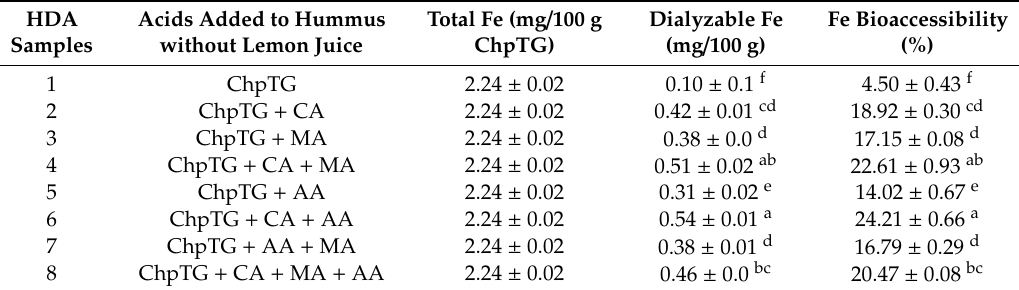
Figure 4. Percentage of iron bioaccessibility (dialyzable iron content (mg/100 g) divided by the total iron content (mg/100 g)) in the eight samples of HDA chosen based on the 2 3 experimental design (full factorial). (HDA: hummus with different acids). Results are expressed as a mean ± IC ( n = 3; IC 95%). Bars not sharing a letter are significantly different ( p < 0.05), according to the one-way ANOVA test followed by Tukey’s post-hoc test at 95% confidence. ChpTG = Chp: chickpea + T: tahini + G: garlic. CA: citric acid, MA: malic acid, AA: ascorbic acid. Each acid is at 4 mmol/100 g of ChpTG. Table 4. Total iron (mg/100 g), dialyzable iron (mg/100 g), and accessible iron (%) in the eight samples of hummus with different acids content (HDA 1 8 ).